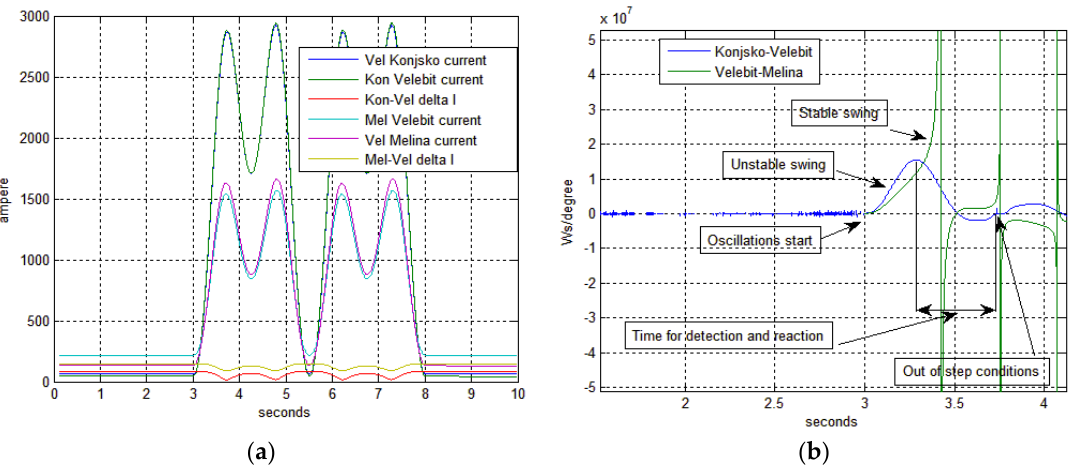
Figure 13. Remedial protection criteria: ( a ) Konjsko-Velebit and Melina-Velebit currents from both line ends with differential current protection (Δ I ). Out-of-step has developed on Konjsko-Velebit line and only stable power swing was present on Melina-Velebit line; and, ( b ) Konjsko-Velebit and Melina-Velebit lines with equivalent transmission system inertia measurements. Out-of-step developed on Konjsko-Melina line and only stable swing was present on Melina-Velebit line.